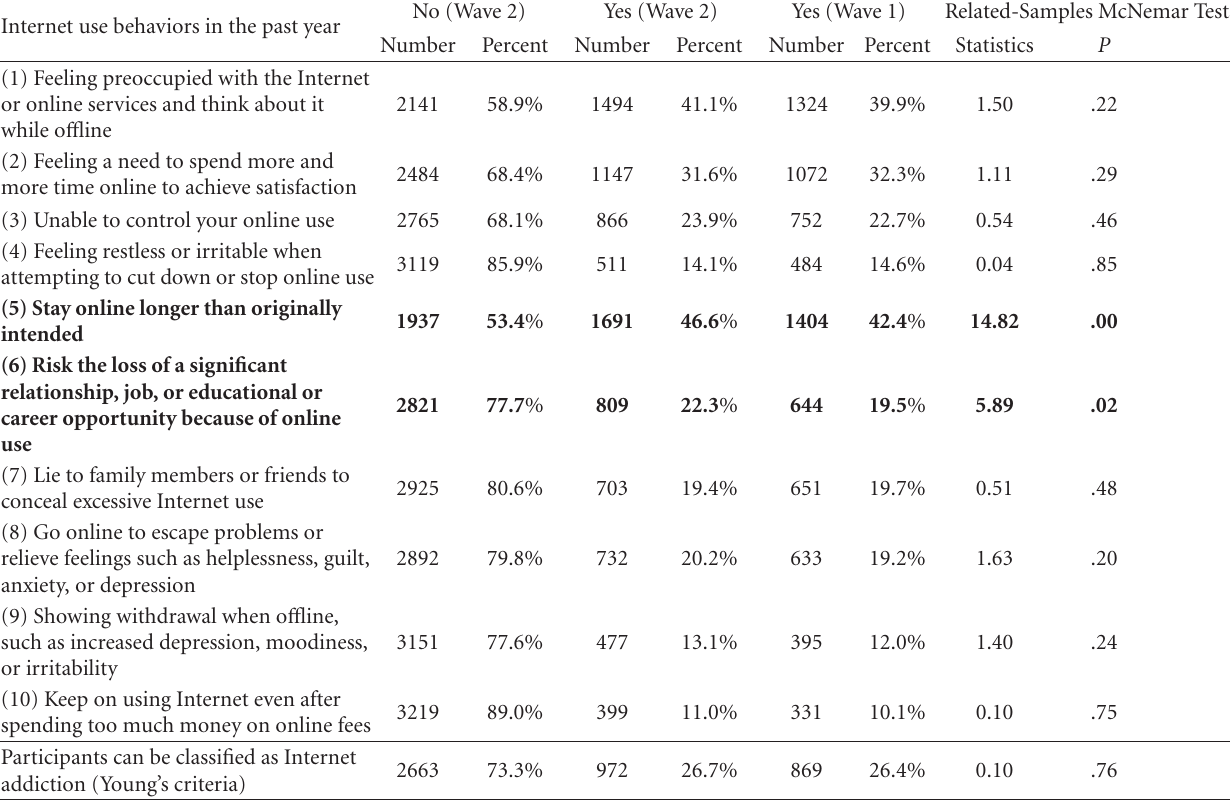
Table 2: Percentage of participants with Internet addiction behavior in two